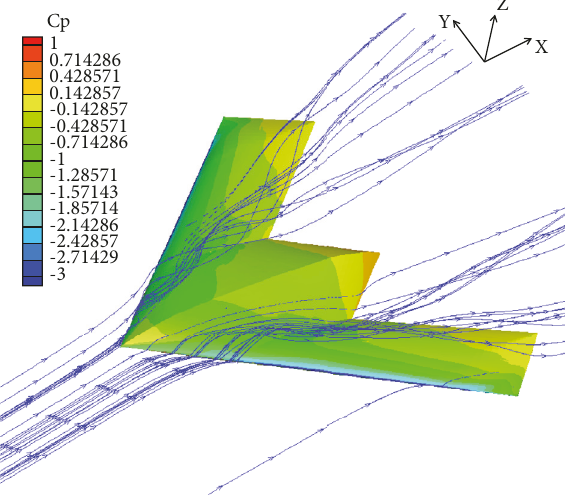
Figure 4: Leading-edge vortex at AoA=15 ∘ .